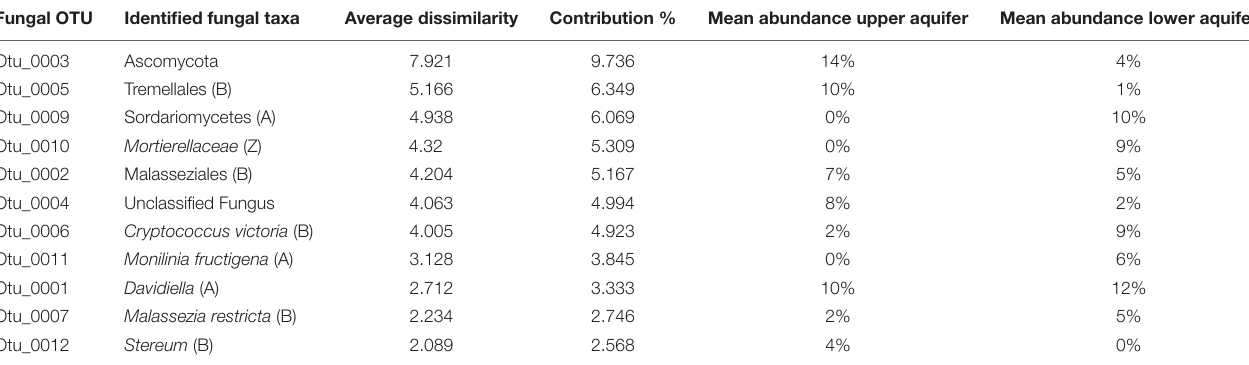
FIGURE 3 | Venn diagram (A) illustrating the number of fungal OTUs exclusively found in the upper and lower aquifer assemblages and OTUs that were found in both aquifers. Relative distribution of fungal phyla (B) and different fungal functional groups (C) found in upper and lower aquifer assemblages in the Hainich CZE. TABLE 3 | Top 10 fungal OTUs that contribute the most to the observed difference in the fungal communities of the upper and lower aquifer assemblages based on SIMPER